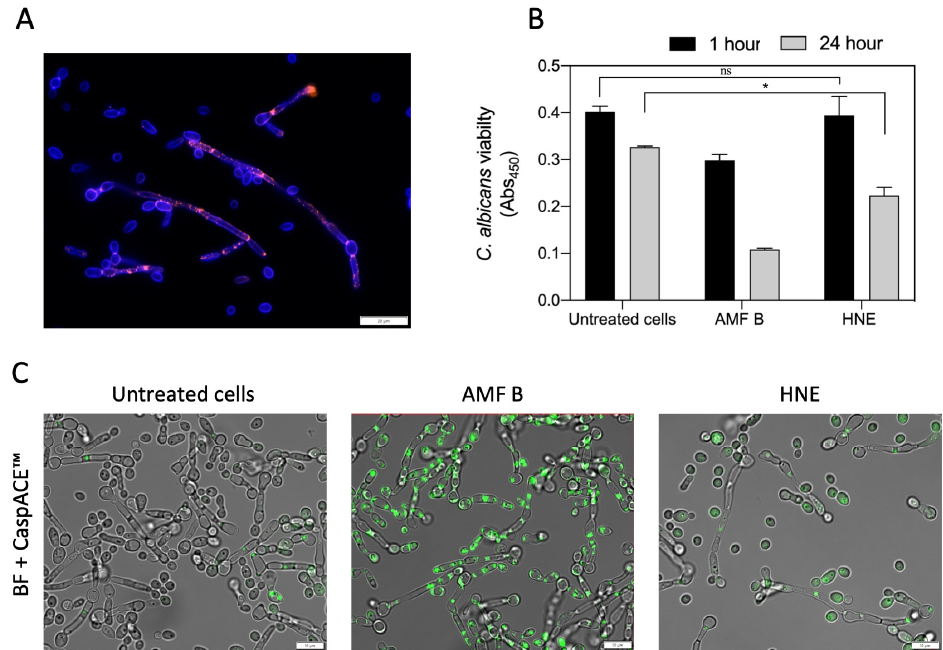
Figure 6. The effect of human neutrophil elastase binding on the viability of C. albicans . ( A ) C. albicans (10 5 cells/mL) cells were grown in a 96-well plate in RPMI medium for 6 hours. HNE was added to the cells at a final concentration of 14 µ g/mL. In order to visualize the bound HNE, the cells were washed with PBS and fixed with 4% PFA. The HNE presence on the fungal cells was identified using mouse anti-HNE antibodies (1:100) and secondary anti-mouse antibodies (1:300) conjugated with Alexa Fluor 555 dye. The C. albicans cell wall was stained with Calcofluor White dye. ( B ) An XTT test was performed to determine the viability of C. albicans after 1 or 24 h of incubation with HNE. Cells treated with amphotericin B (AMF B; 2.5 µ g/mL) served as a positive control. A representative result of three independent experiments is presented. In order to assess the statistical significance between groups ( n = 2), an unpaired t -test was performed. The results were considered statistically significant at a p -value of < 0.05 (* p ≤ 0.0332), or not statistically significant (ns) for p > 0.1234. ( C ) In addition, the viability of C. albicans was determined using the CaspACE ™ FITC-VAD-FMK In Situ Marker. The imaging was performed with an Olympus IX73 microscope in the FITC